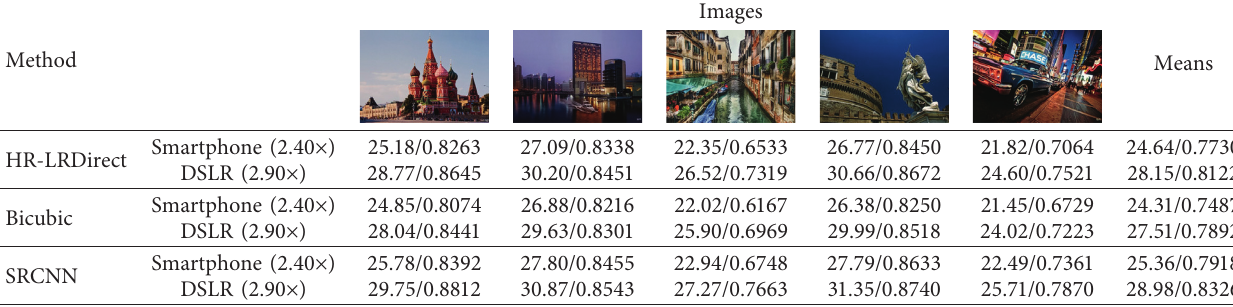
Table 3: The performances (PSNR/SSIM) under different L and R on smartphone-based City100 database ( G � 6 and T � 3 fixed). R